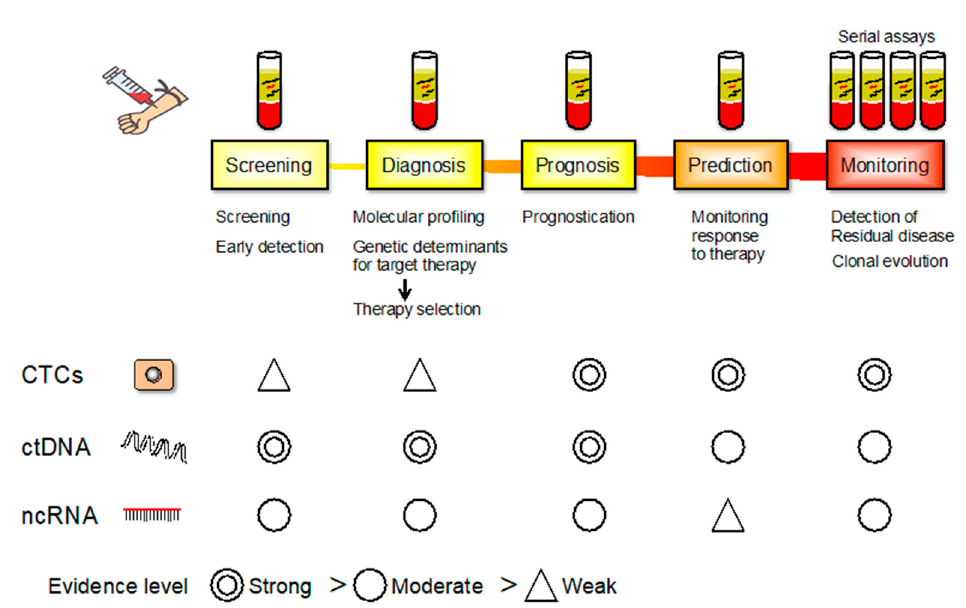
Figure 3. Potential applications of liquid biopsies during the course of GC management. Evidence level is shown.